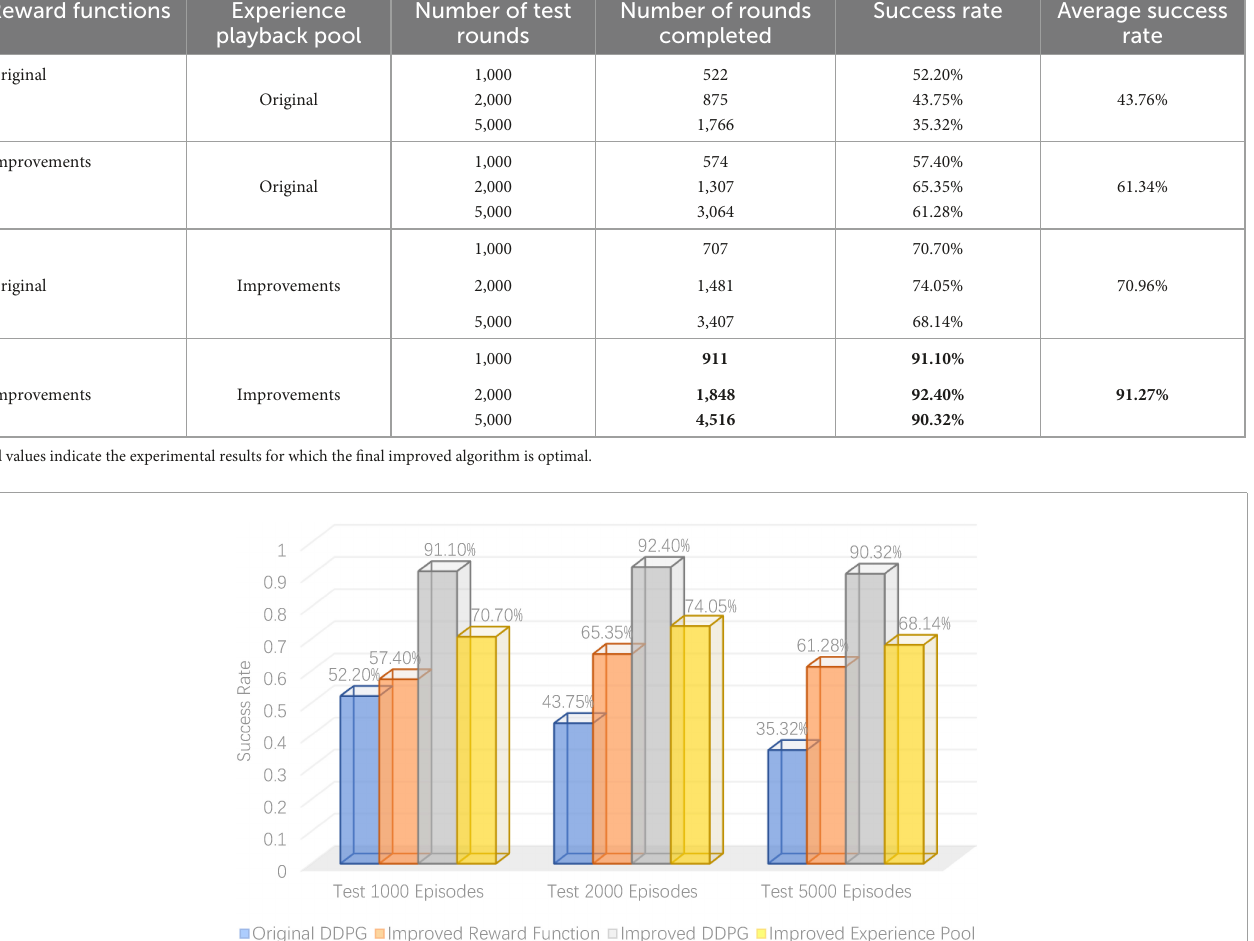
FIGURE13 Visual comparison of test success